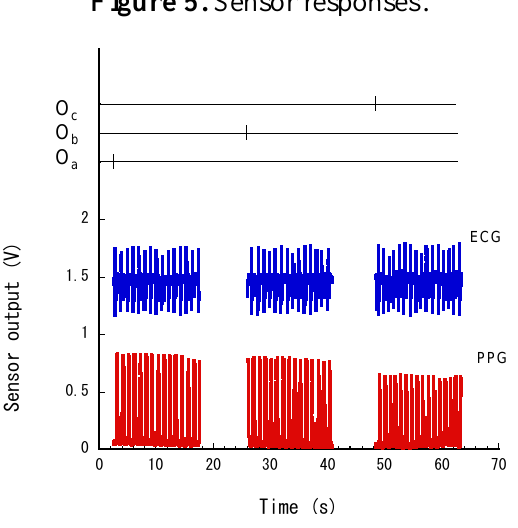
Figure 5. Sensor responses.